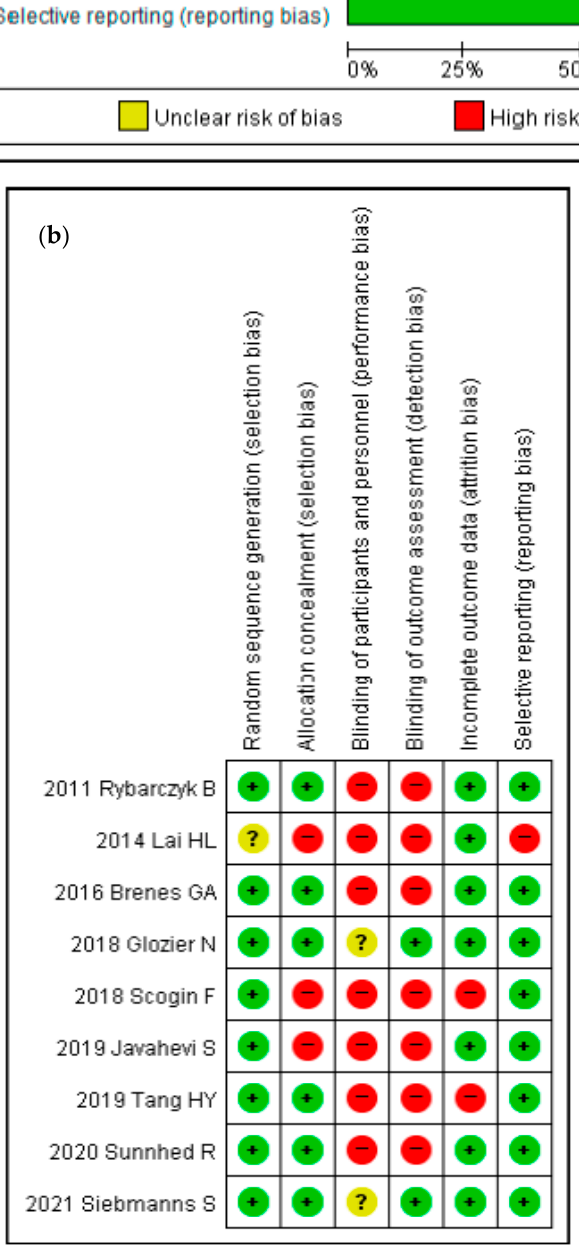
Figure 2. Quality assessment. ( a ) Risk of bias graph. ( b ) Risk of bias summary.